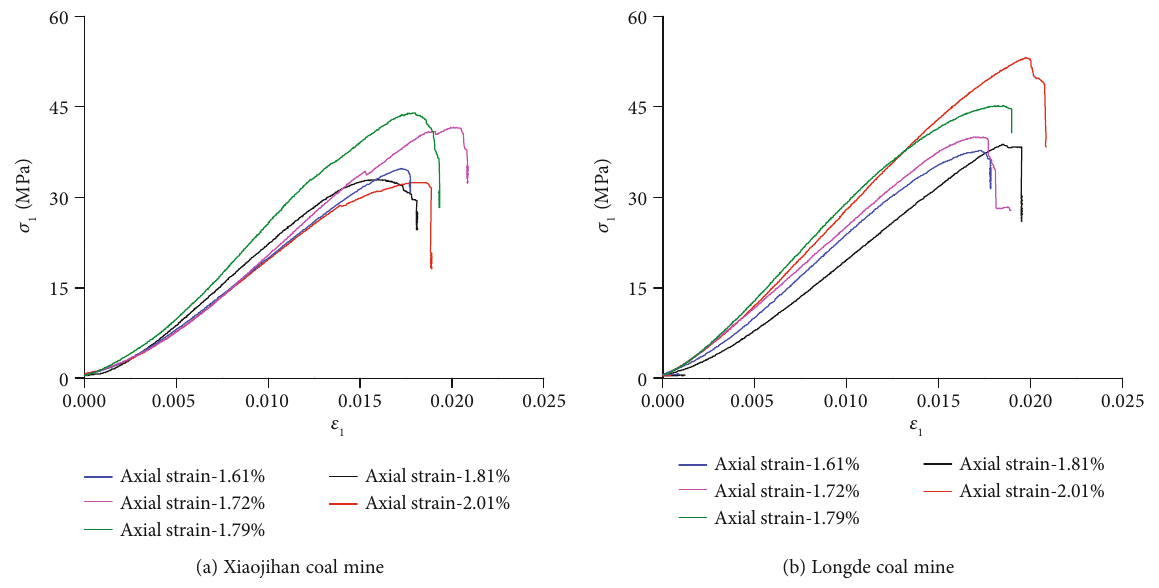
Figure 12: The stress-strain curves of two kinds of specimens under con fi ning pressure of 2MPa. Table 3: The damage load, peak stress, and peak strain of water-bearing specimens under con fi ning pressure of 2MPa. Specimen no.